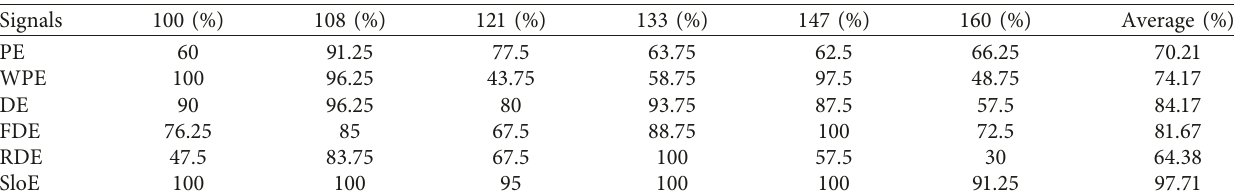
Table 3: Identification ratios of the